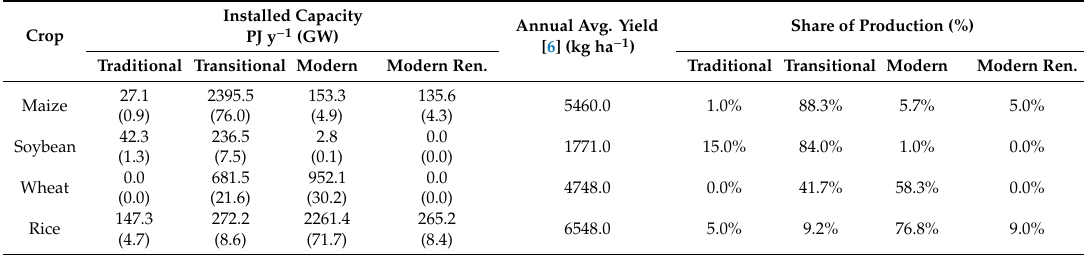
Table 10. Existing capacity per mechanisation Level for